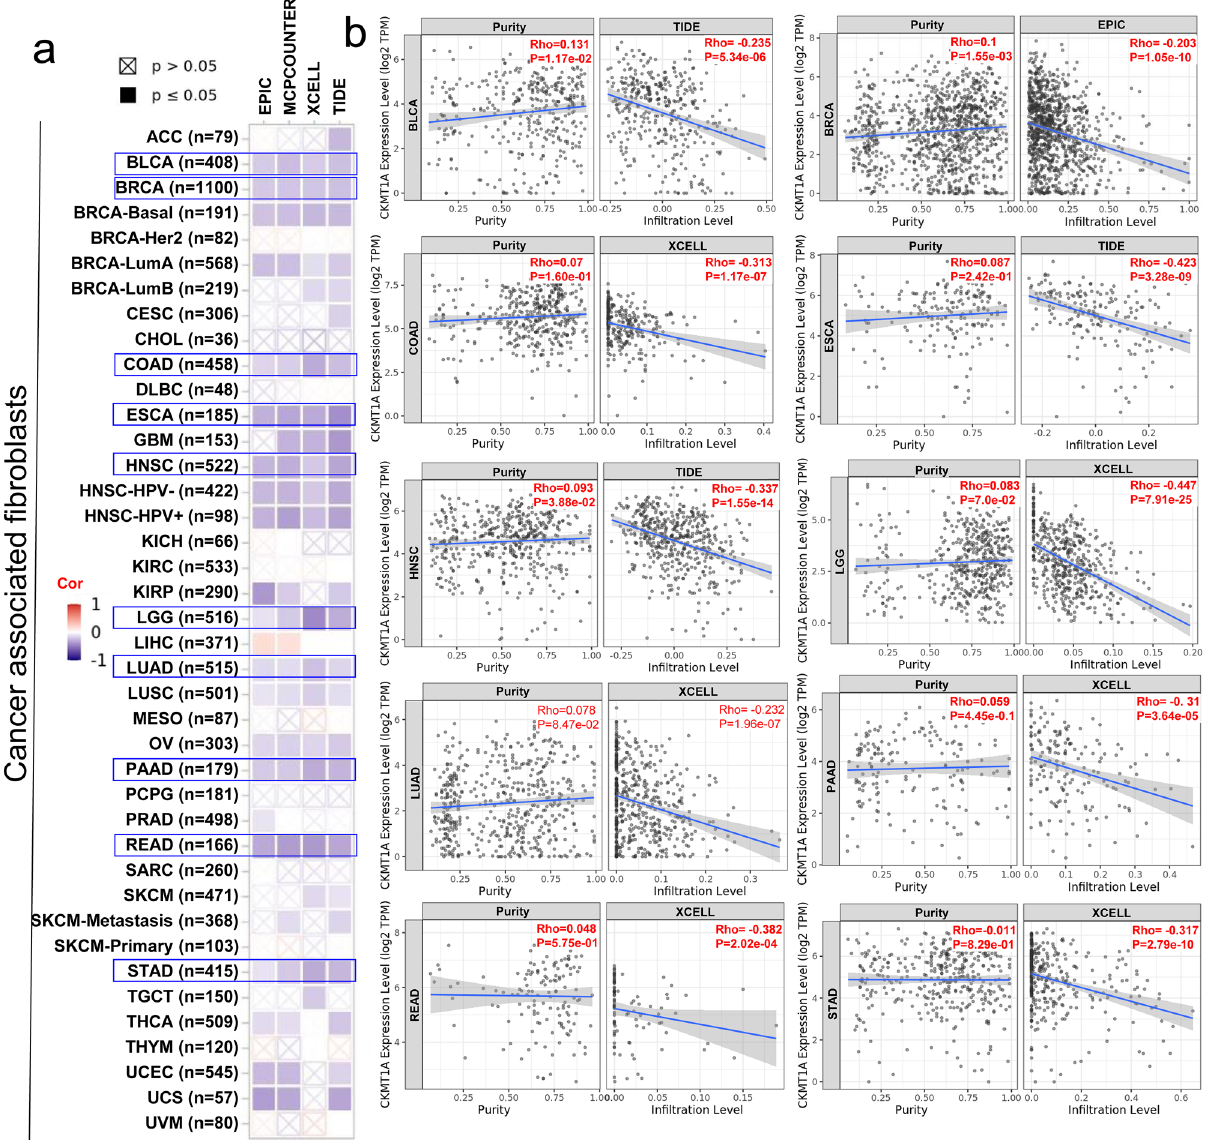
Figure 4. Correlation analysis between the expression of CKMT1A and immune infiltration of cancer- associated fibroblasts. ( a ) The correlation map between CKMT1A expression level and the infiltration level of cancer-associated fibroblasts by EPIC, MCPCOUNTER, XCELL and TIDE algorithms across all types of cancer in TCGA. ( b ) The relationship of CKMT1A and infiltration level of cancer-associated fibroblasts in BLCA, BRCA, COAD, ESCA, HNSC, LGG, LUAD, PAAD, READ and STAD. Rho, The Value of Spearman’s